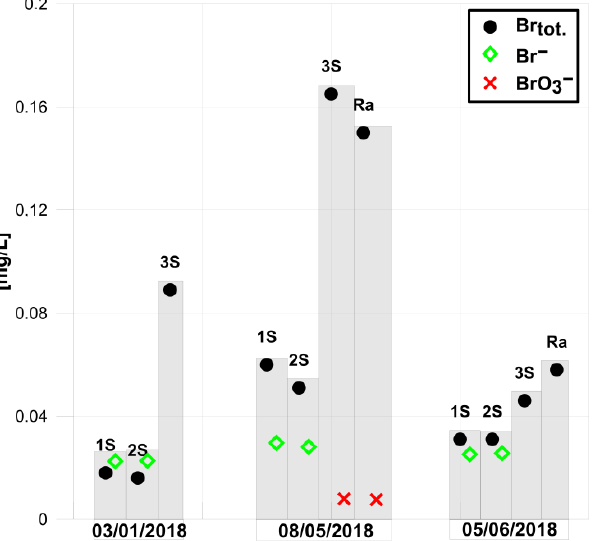
Figure 5. Concentrations of bromine, bromide and bromates in raw (1S) water, after filtration and UV radiation (2S), after disinfection (3S) and at users ’ homes (Ra).